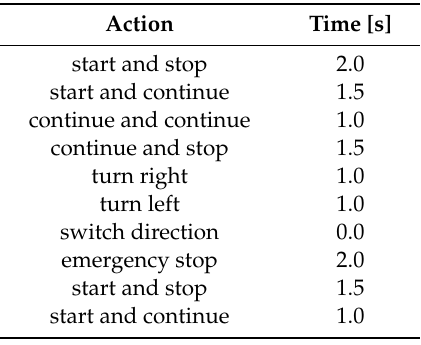
Table 1. Durations of the itinerary actions.